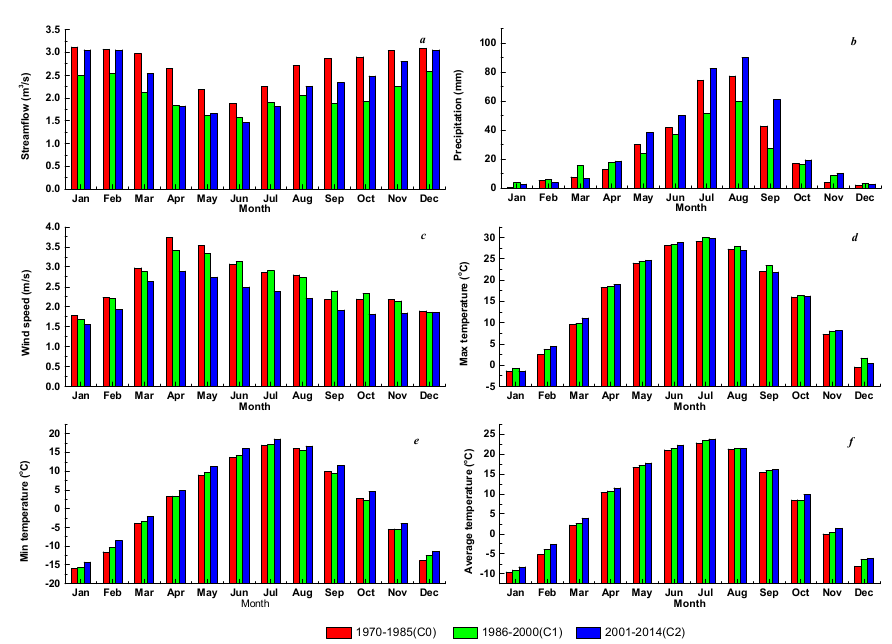
Figure 7. Change variation of ( a ) mean monthly streamflow; ( b ) precipitation; ( c ) wind speed; ( d ) maximum temperature; ( e ) minimum temperature; and ( f ) average temperature of the Hailiutu River basin.